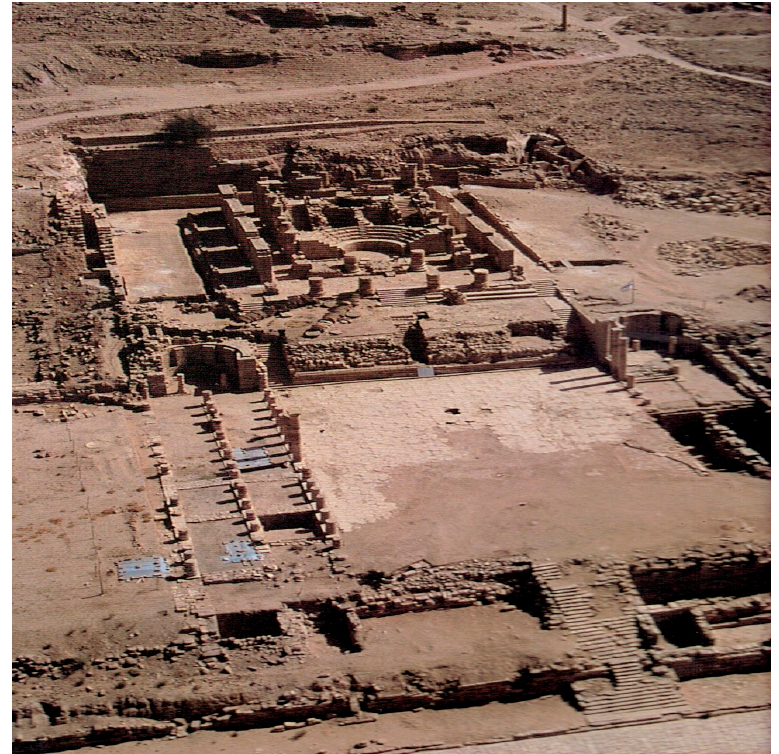
Figure 12. The Great Temple.